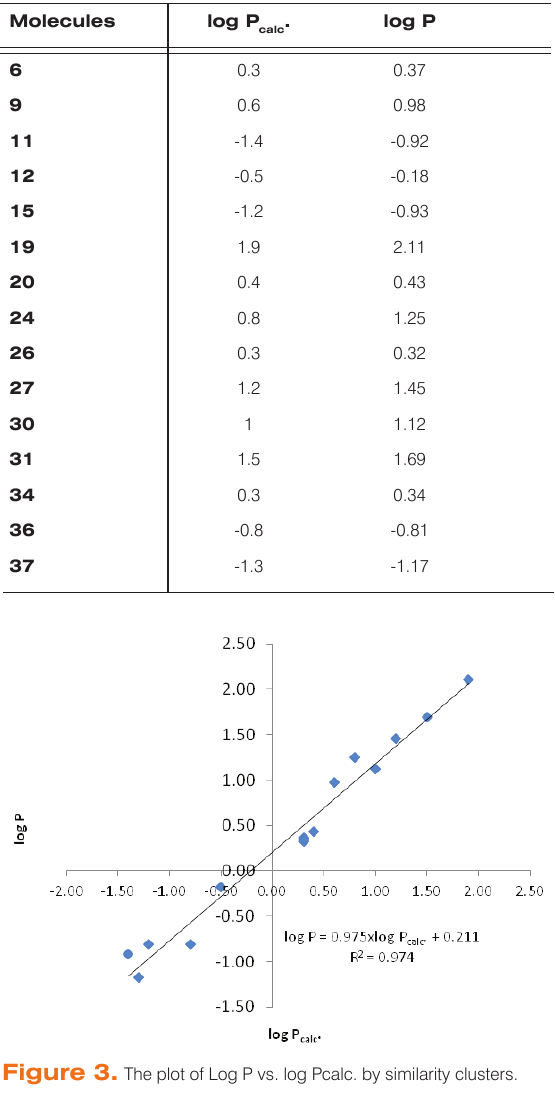
Figure 3. The plot of Log P vs. log Pcalc. by similarity clusters.